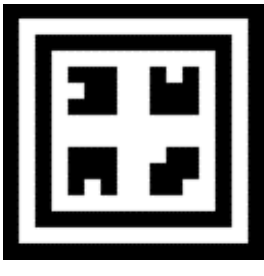
Figure1. The self-designed marker